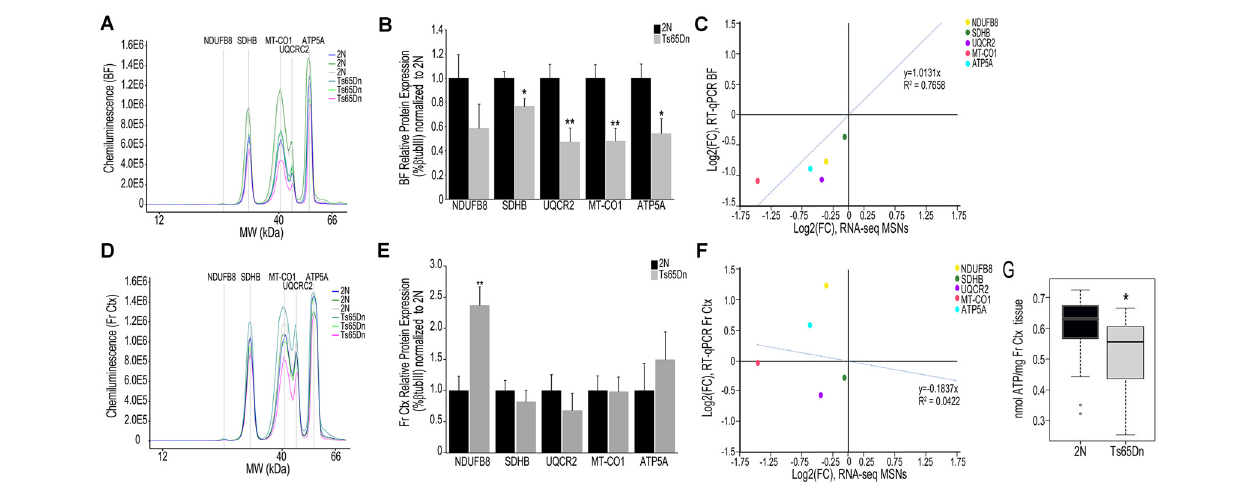
FIGURE 3 | Interrogation of oxidative phosphorylation Complex I-V subunit protein expression within the trisomic basocortical circuit. (A) Representative digital signatures of each assayed protein raw expression levels (y-axis) and molecular weight (x-axis) from Ts65Dn and 2N BF tissue homogenates. (B) Bar graph represents relative protein levels (normalized to beta-tubulin ( β TubIII) as a percentage of 2N expression in BF tissue homogenates. Black bars represent 2N and gray bars indicate Ts65Dn (SEM indicated by error bars). (C) Correlation plot association between MSN BFCN RNA-seq LFC (x-axis) and BF protein level LFC (y-axis) indicating a high correlation. (D) Representative digital signatures of each assayed protein raw expression levels (y-axis) and molecular weight (x-axis) from Ts65Dn and 2N Fr Ctx tissue homogenates. (E) Bar graph represents relative protein levels (normalized to β TubIII) as a percentage of 2N expression in Fr Ctx tissue homogenates (SEM indicated by error bars). (F) Correlation plot association between MSN BFCN RNA-seq LFC (x-axis) and Fr Ctx protein level LFC (y-axis) indicating no significant correlation. (G) Box and whisker plots highlight downregulation of ATP levels in trisomic Fr Ctx. Key: * p < 0.05, ** p <